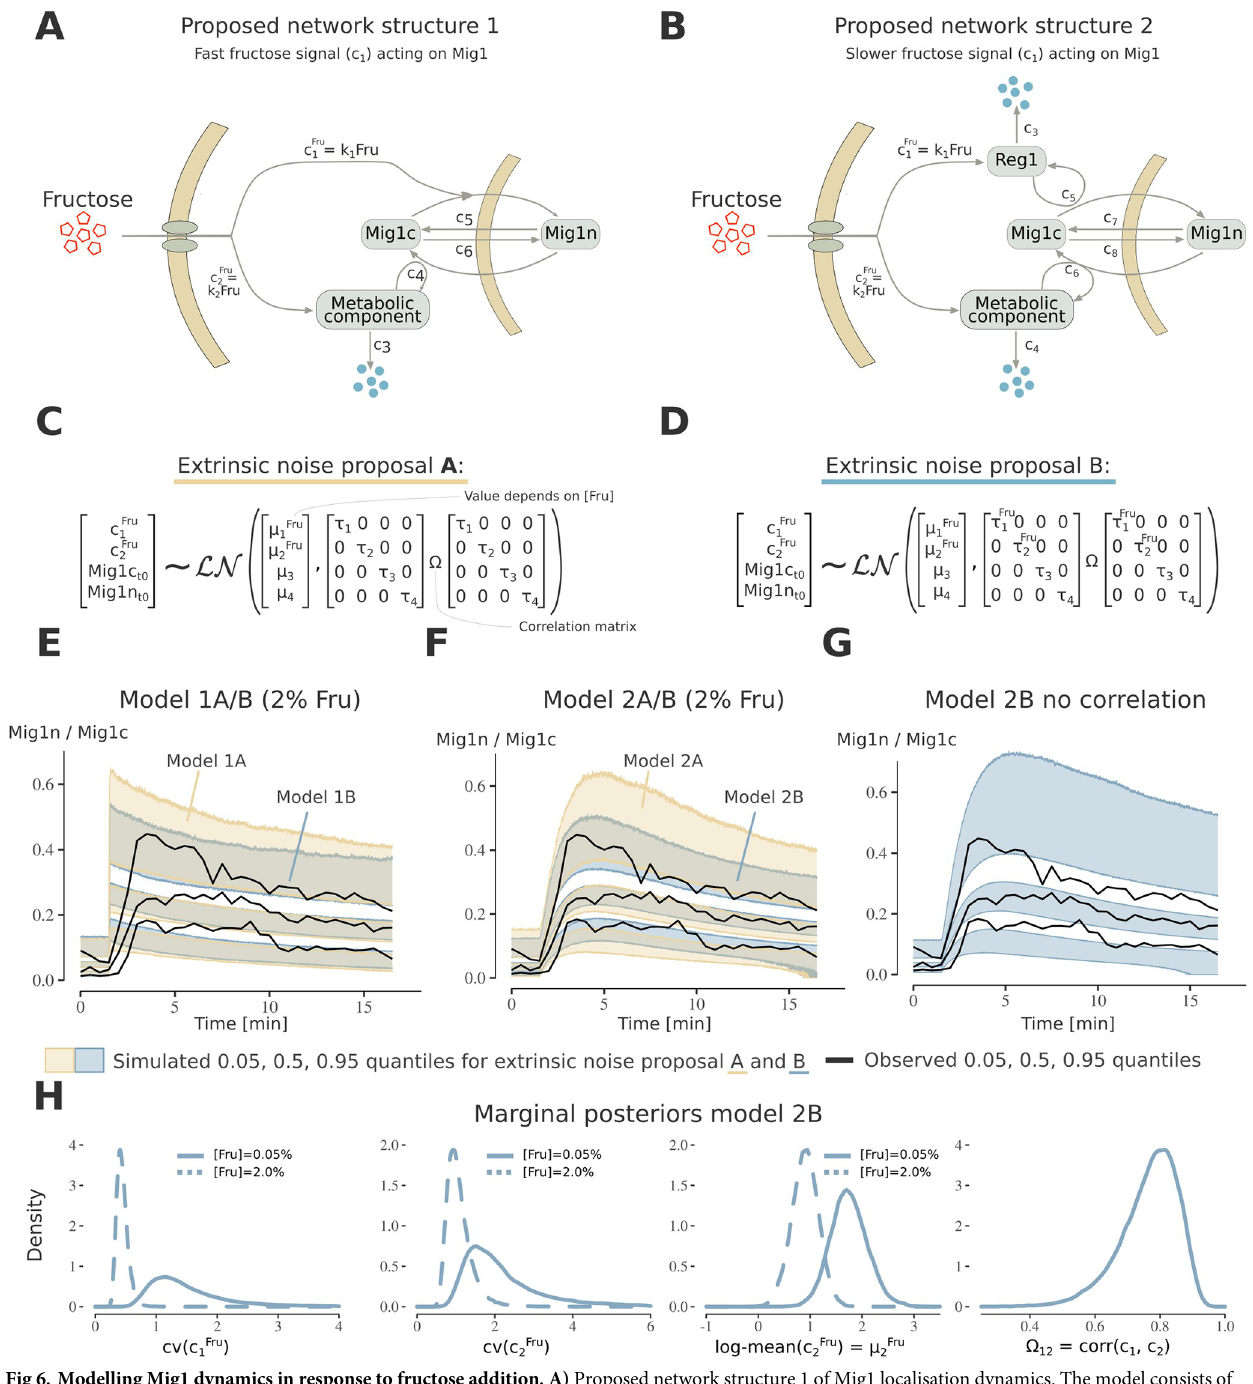
Fig 6. Modelling Mig1 dynamics in response to fructose addition. A) Proposed network structure 1 of Mig1 localisation dynamics. The model consists of three states, nuclear Mig1 (Mig1n), cytosolic Mig1 (Mig1c) and a metabolic component. The model proposes that a fructose signal directs Mig1 nuclear import, and that nuclear export is directed by a metabolic signal. B ) Proposed network structure 2. In addition to structure 1 Mig1 nuclear entry is modelled as delayed due to Reg1 activation. C) Modelling proposal A of extrinsic noise. Since ( c 1 , c 2 ) encompass multiple cellular processes, and initial Mig1-levels are cell-varying, extrinsic noise was modelled by letting these follow a full log-normal distribution. Since ( c 1 , c 2 ) include the external fructose we model different log-mean values for the 2% and 0.05% conditions. D) Extrinsic noise proposal B. Additionally to proposal A, we model fructose dependent variability ( τ - values) for ( c 1 , c 2 ). E-F) Posterior visual check for the 2% fructose data for model structure 1 and 2, using extrinsic noise-proposal A and B. The credibility intervals (bands) were obtained as in Fig 2. Black lines are the observed quantiles. Model structure 2 with extrinsic noise proposal B (model 2B) best describes the observed trend, and cell heterogeneity. g) Posterior visual check as in F) for model 2B with no correlation between ( c 1 , c 2 , Mig 1 n , Mig 1 c ) (diagonal Ω ). This yields an increase in cell-to-cell variability seen by the 0.05, and 0.95 quantile credibility intervals. H ) Marginal posterior distribution for a subset of parameters in model 2B. The log-normal coefficient of variations cv ð c Þ ¼ exp ð t 2 Þ (cid:0) 1 are fructose dependent, and ( c 1 , c 2 ) are strongly correlated. i i